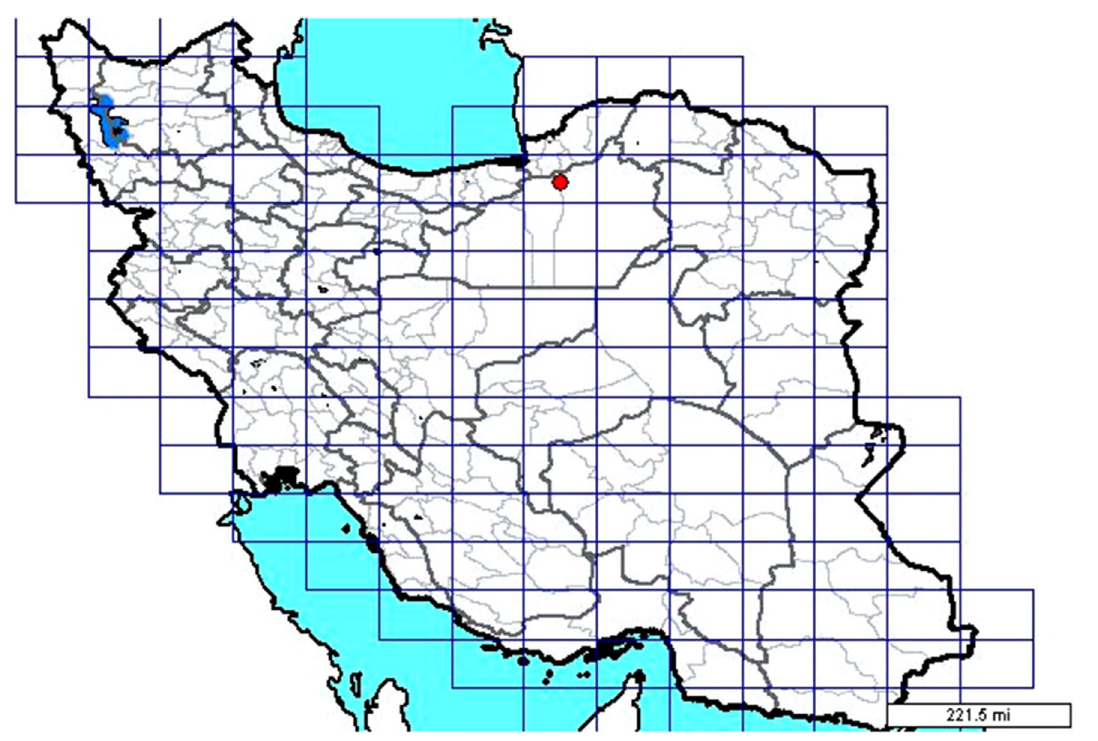
Fig. 1 Semnan mines in the northeast of Iran (Sharghe Haftdareh)